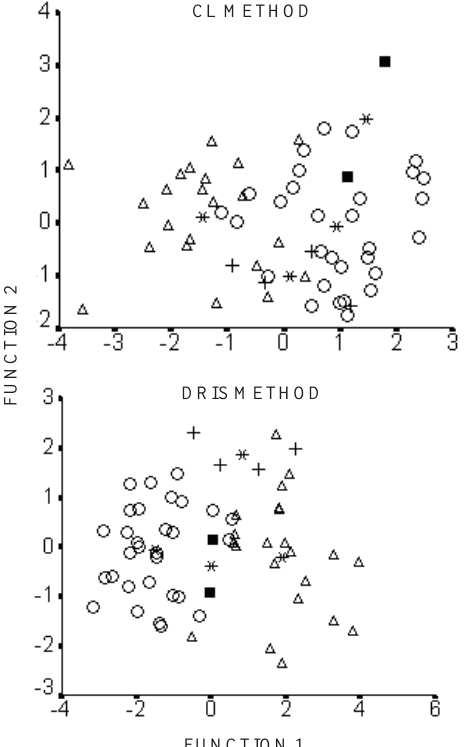
Figure 1. Scatterplot of Mahalanobis distances between coffee crops based on nutritional status by Critical Level method (CL method) and Diagnosis and Recommendation Integrated System method (DRIS method). (group centroids, ; PVA: Red-Yellow Argissol, +; LVA: Red-Yellow Latossol, O ; LV: Red Latossol LA: Yellow